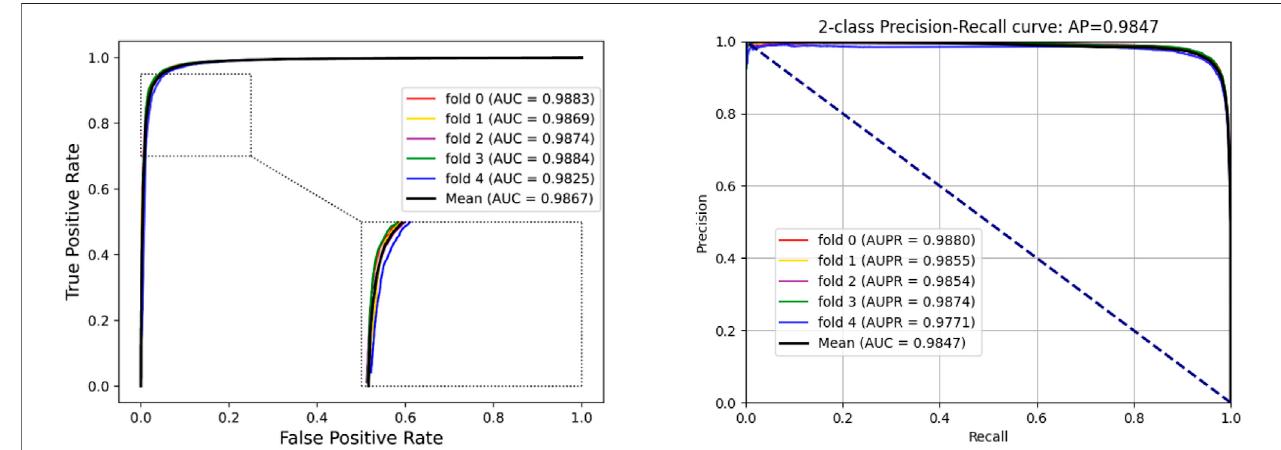
FIGURE 2 | ROC and PR curves yielded by the DWPPI model on the Zea mays dataset with the multiple feature.